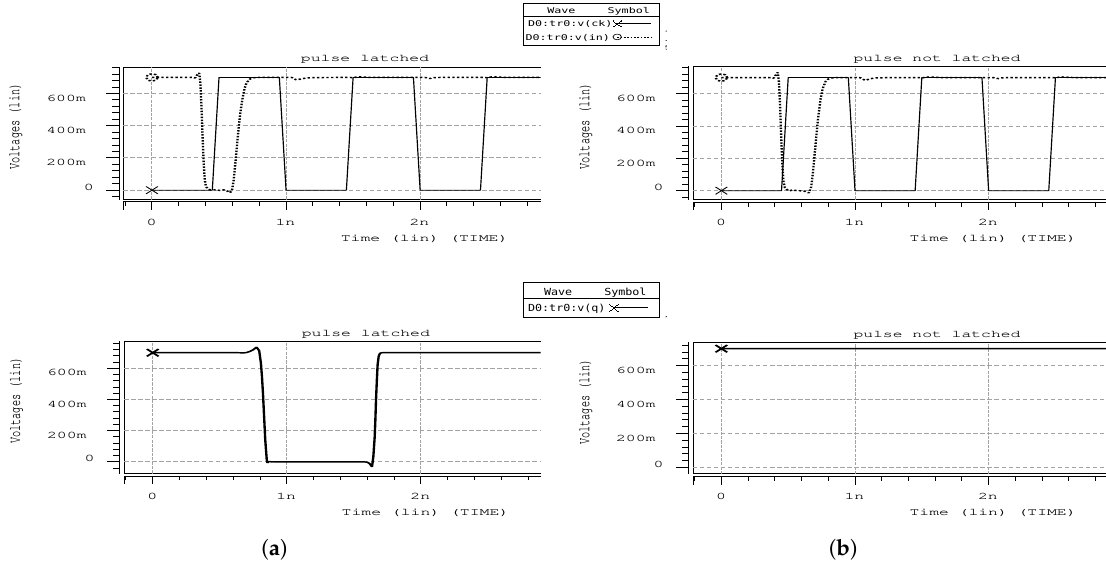
Figure 4. Transient pulse when ( a ) it is latched and ( b ) it is not